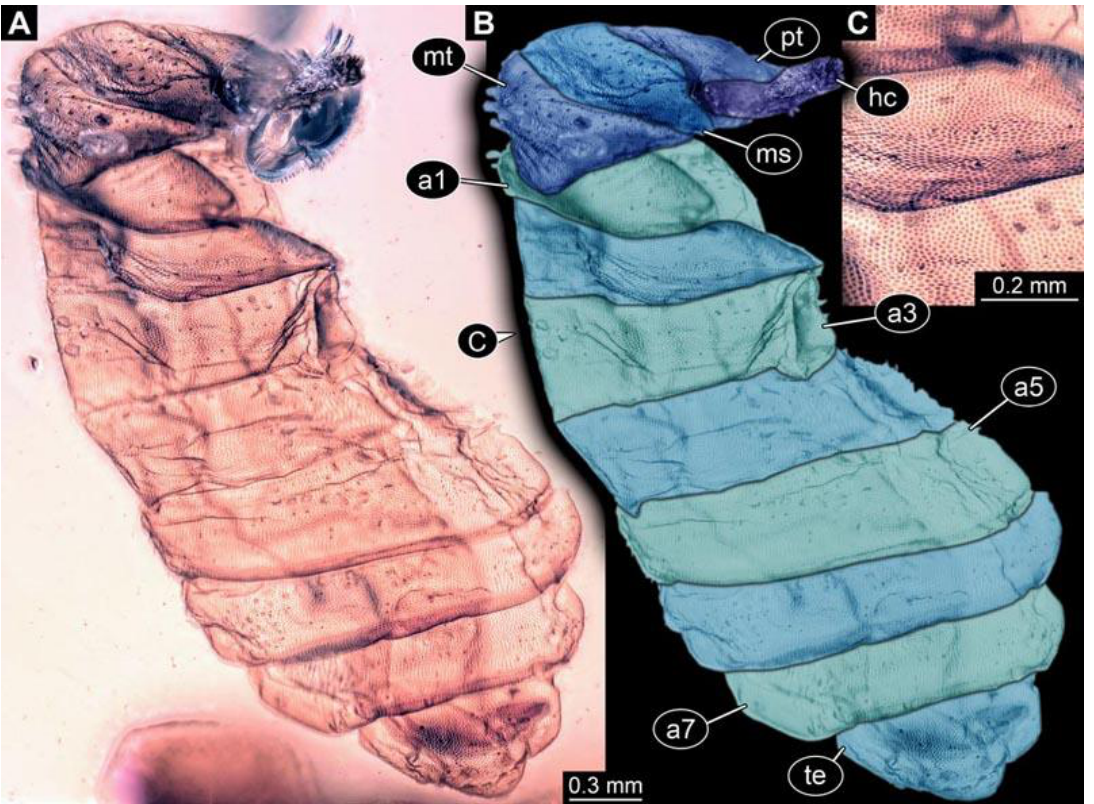
Figure 2. Fossil larva of morphotype 1, specimen PED 0617. ( A ). Full view of specimen. ( B ). Colour- marked. ( C ). Close-up of surface structure. Abbreviations: a1–a7 = abdomen units 1–7; hc = head capsule; ms = mesothorax; mt = metathorax; pt = prothorax; te = trunk